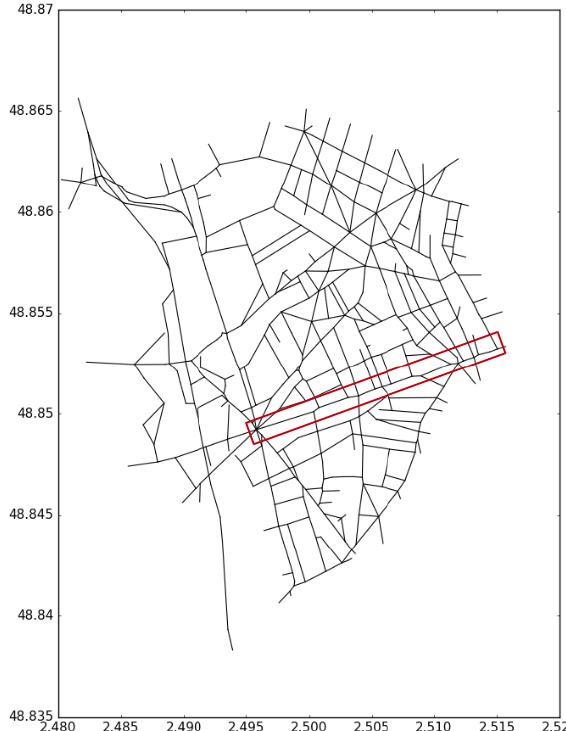
Figure 2. The street network, with Boulevard Alsace Lorraine high- lighted in the red